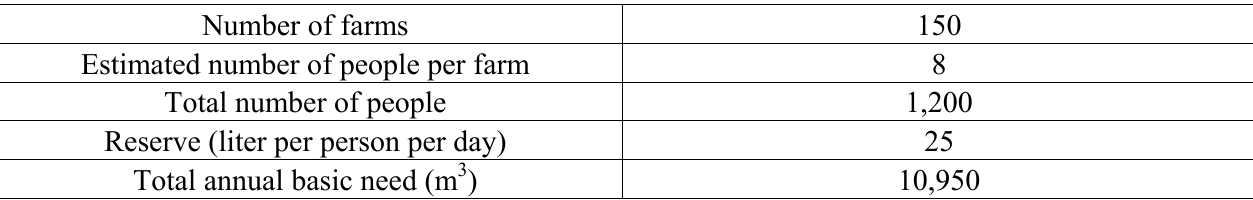
Table 5. Basic Human Need Calculation.